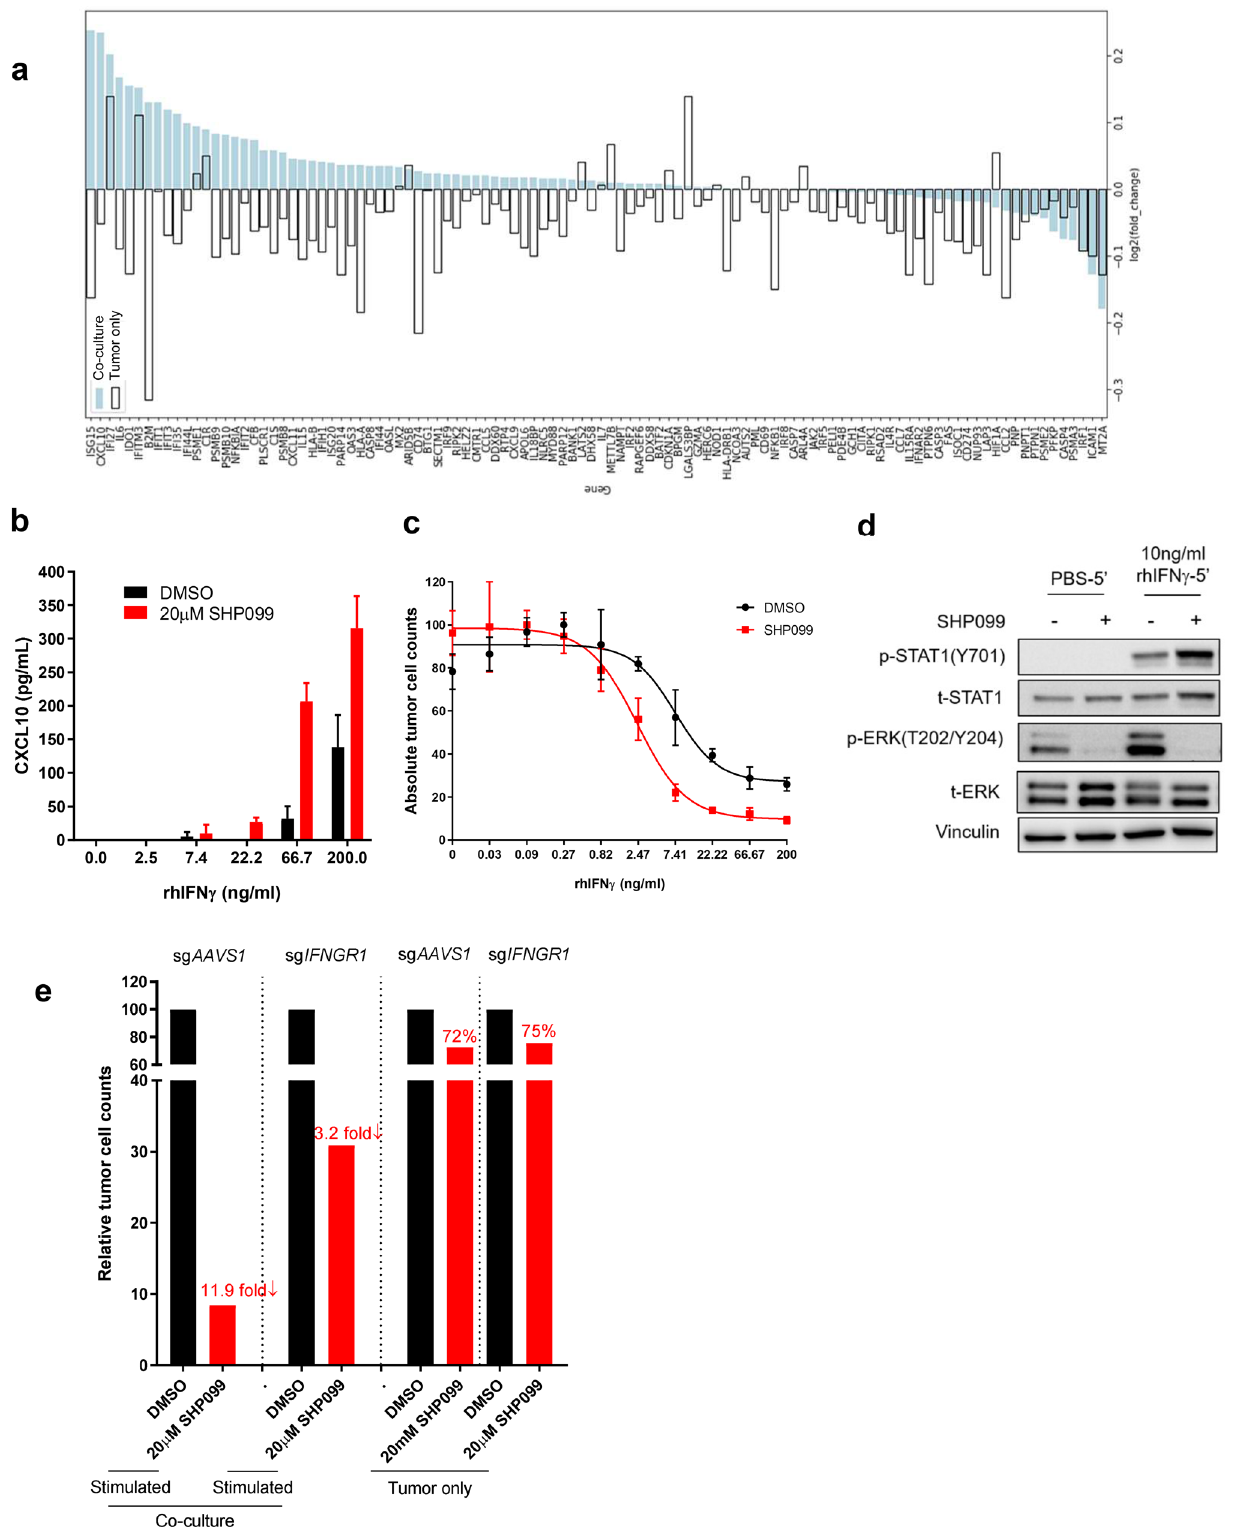
Figure 4. SHP2 mediates anti-tumor immunity via IFNγ signaling. ( a ) scRNAseq data showing IFNγ signaling signature genes expression level change induced by SHP099. ( b ) ELISA analysis of CXCL10 level in supernatant collected from tumor spheroids treated with IFNγ of gradient concentration in the absence or presence of SHP099 for 6 days. ( c ) Dose response curve of OVCAR-8 tumor spheroids to IFNγ treatment in the absence or presence of SHP099 after 6 days. ( d ) Immunoblotting of p-STAT1 and p-ERK in OVCAR-8 tumor spheroids after different treatments. ( e ) Absolute tumor cell counts from each well of 384-well Elplasia plate after 6 days co-culture of OVCAR-8-sg AAVS1 or OVCAR-8-sg IFNGR1 spheroids with PBMCs. Relative fold change of absolute tumor counts (SHP099 treated over DMSO group) is